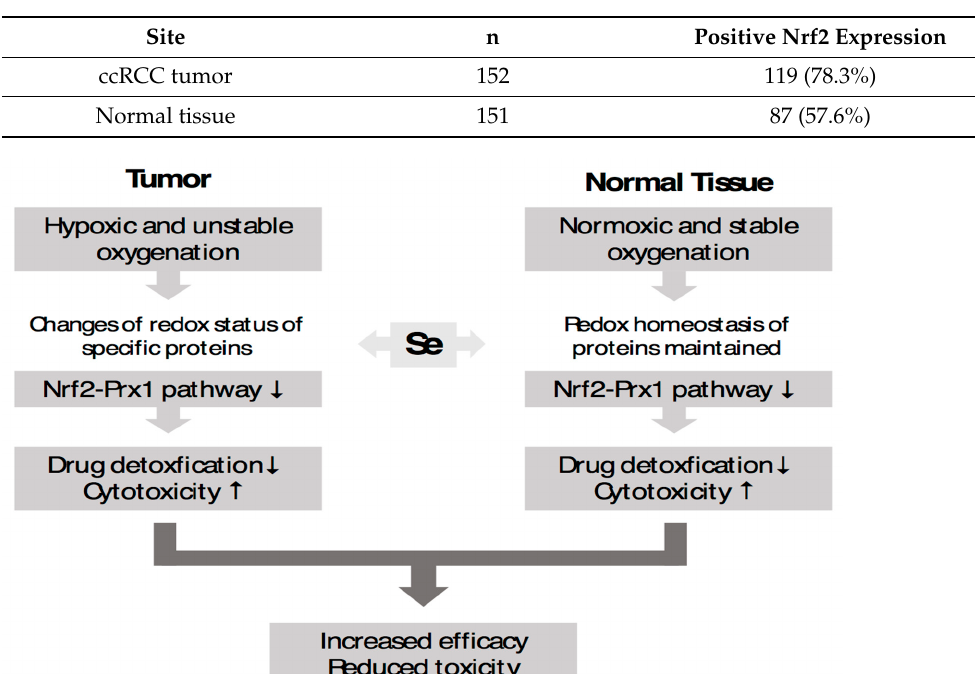
Figure 3. Biomarkers’ expression associated with the overexpressed nuclear factor erythroid 2-related factor 2 (Nrf2). ↑ Activator and inhibitor. Onco-miRs, oncogenic microRNAs; HIFs, hypoxia-inducible factor-1 α /2 α ; KRAS, BRAF, c-myc, Kristen rat sarcoma virus, B-raf proto-oncogene, serine/threonine kinase, and c-myc is a proto-oncogene; TGF-ß, transforming growth factor-ß; Th17, T-helper 17 cells; Foxp3/Treg, transcription factor forkhead box protein/T regulatory cell; PD-L1, programmed death ligand 1; GSK-3ß, glycogen synthase kinase-3-beta; VEGF, vascular endothelial growth factor; Th1/2, T-helper-type 1/2 cells; MDSC, myeloid-derived suppressor cells [75]. Table 3. Expression of Nrf2 in ccRCC tumors and normal tissue [69]. Difference in the expression levels between tumor and normal tissue is significant, with p < 0.001.